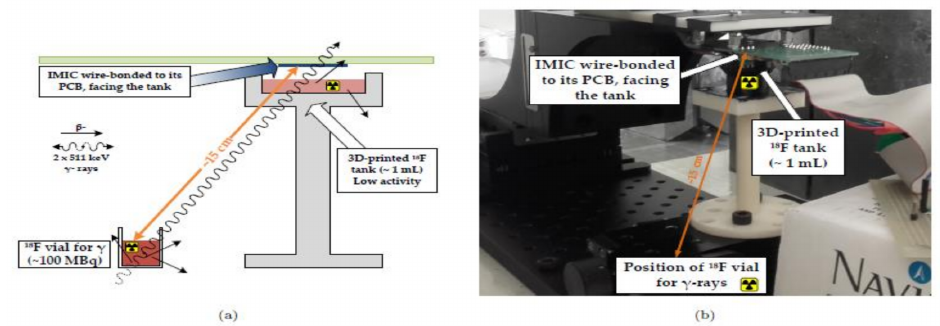
Figure 23. ( a ) Schematic of the experimental setup. ( b ) Physical setup. Figure adapted with permis- sion from